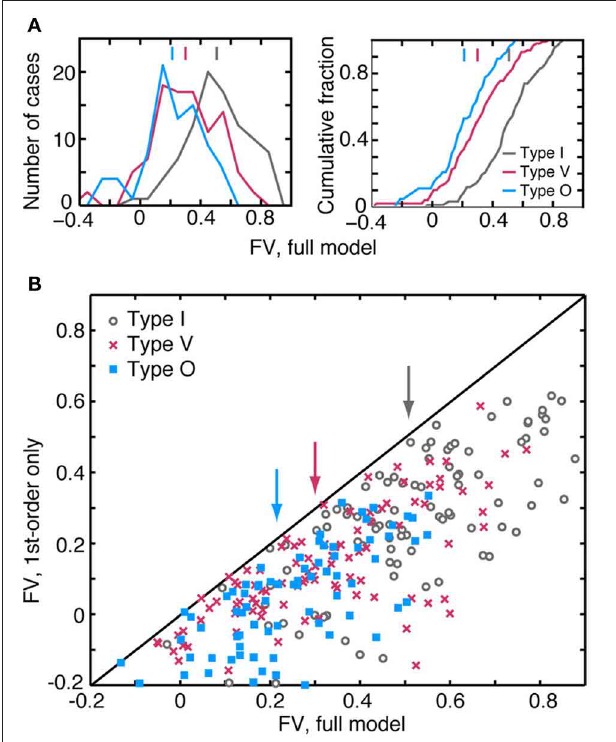
FIGURE 7 | Quality of the model predictions as measured by fv in leave-one-out cross validation tests. Each plot contains an aggregation of prediction data obtained at different sound levels. A neuron is usually represented multiple times, once at each sound level and also at pairs of adjacent sound levels. (A) Distribution (left) and cumulative distribution (right) of fv- values for the three response types. Vertical lines at the top of the plots show median fv -values. Differences in the distributions across the neuron types are statistically significant (rank sum test with Bonferroni correction; I vs. V and I vs. O, P << 0 . 001; V vs. O, P < 0 . 02). (B) Comparison of the best prediction quality ( fv ) for a full binaural model containing all 2nd-order terms (abscissa) and a model containing only 1st-order terms (ordinate). Ten data points with ordinate values < − 0 . 2 are not shown, but are included in the statistics. Vertical arrows indicate median fv -values for each of the neuron types.